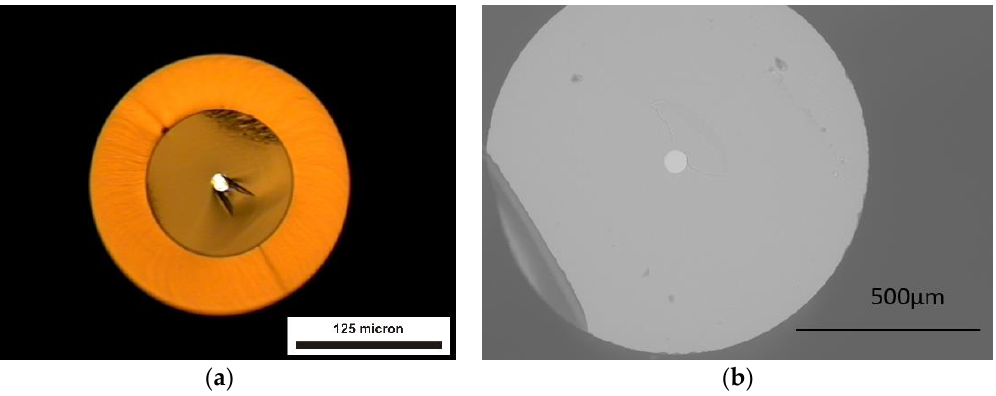
Figure 5. ( a ) Optical micrograph of a polymer-coated, glass-clad germanium (Ge) core optical fiber and ( b ) An electron micrograph of an uncoated glass-clad silicon core optical fiber.